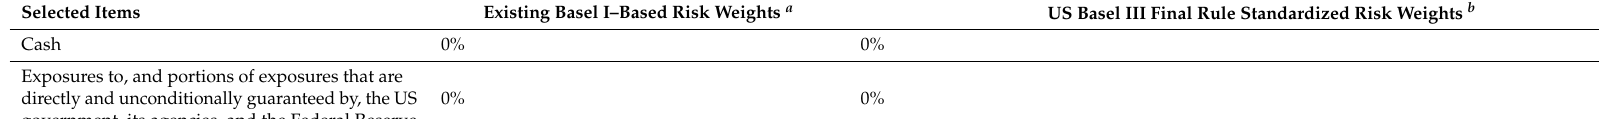
Table 5. Basel I and Basel III: US Risk Weights for On-Balance-Sheet and Off-Balance-Sheet Items for the Standardized